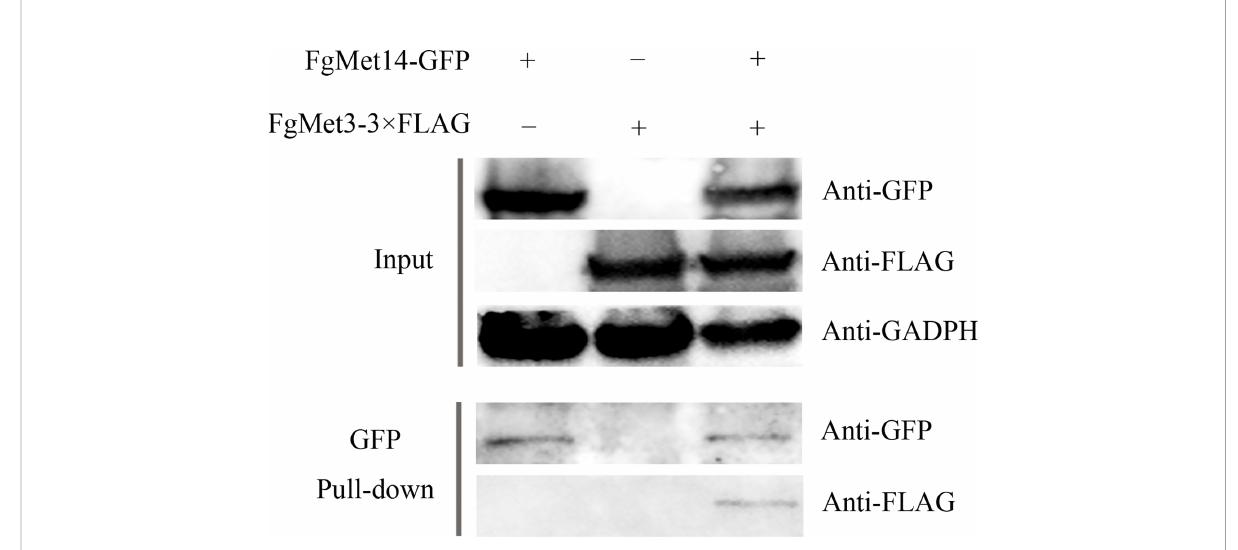
FIGURE 1 FgMet3 interacts with FgMet14. Co-immunoprecipitation (Co-IP) assay con fi rmed the interaction between FgMet3 and